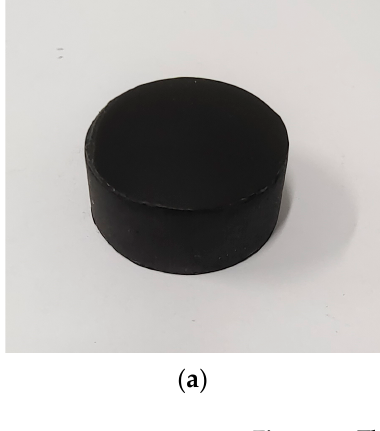
Figure 1. The cross-sectional vulcanized rubber samples for further detection. ( a ) Sample with diameter of 29 mm and thickness of 12.5 mm for detection of density, Shore A hardness and rebound resilience; ( b ) Samples for detection of elongation at break, modulus at 100% and tensile strength.